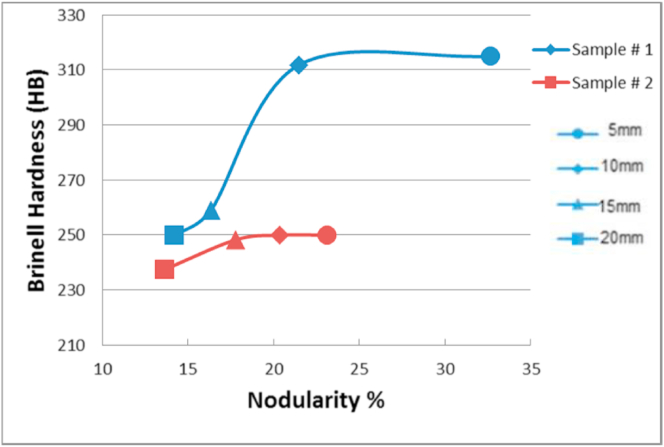
Brinell hardness of 80–100% pearlite content as a function of nodularity %.